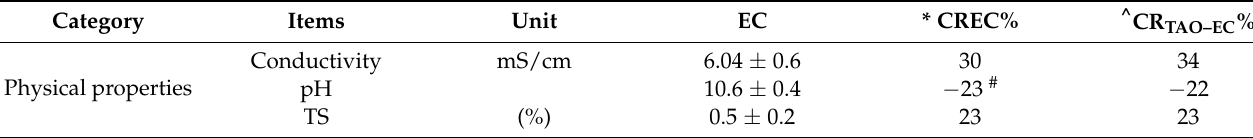
Table 4. Physiochemical properties during the EC